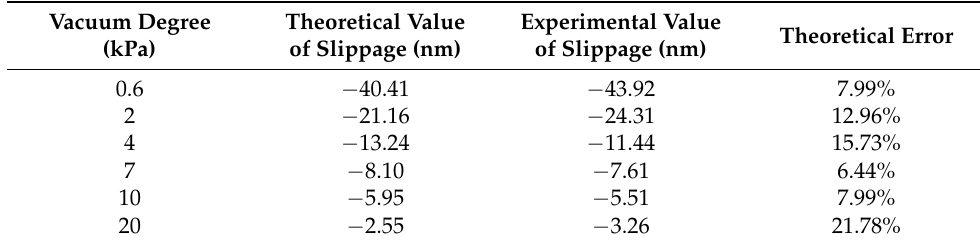
Table 6. Theoretical value, experimental value, and error of slippage (uniform motion phase to stable deceleration phase).